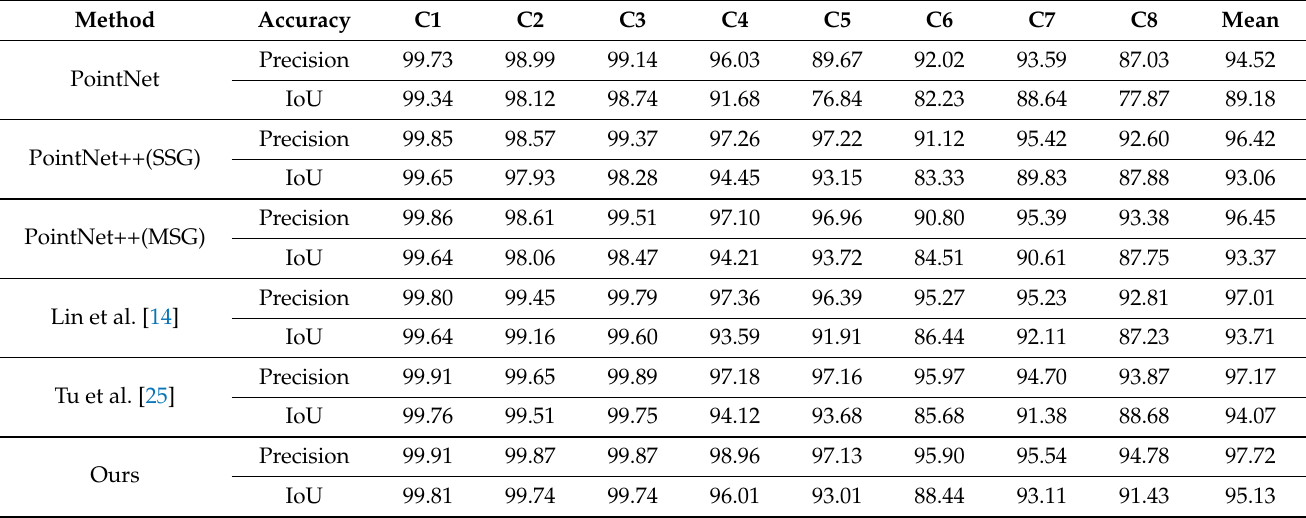
Table 1. Evaluating accuracy results. Point cloud categories are C1: pole, C2: catenary wire, C3: contact wire, C4: insulator, C5: dropper, C6: steady arm, C7: registration arm, C8: cantilever.